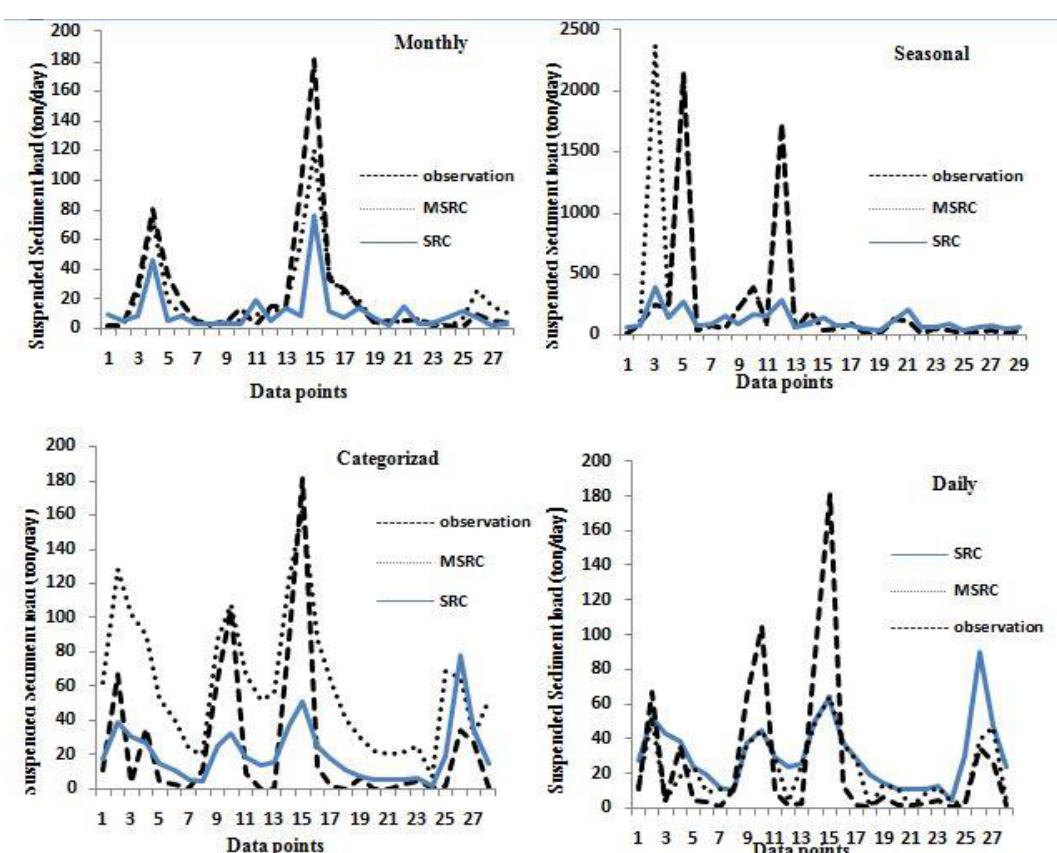
Fig. 3. Comparison of SRC and modified SRC (MSRC) with observational